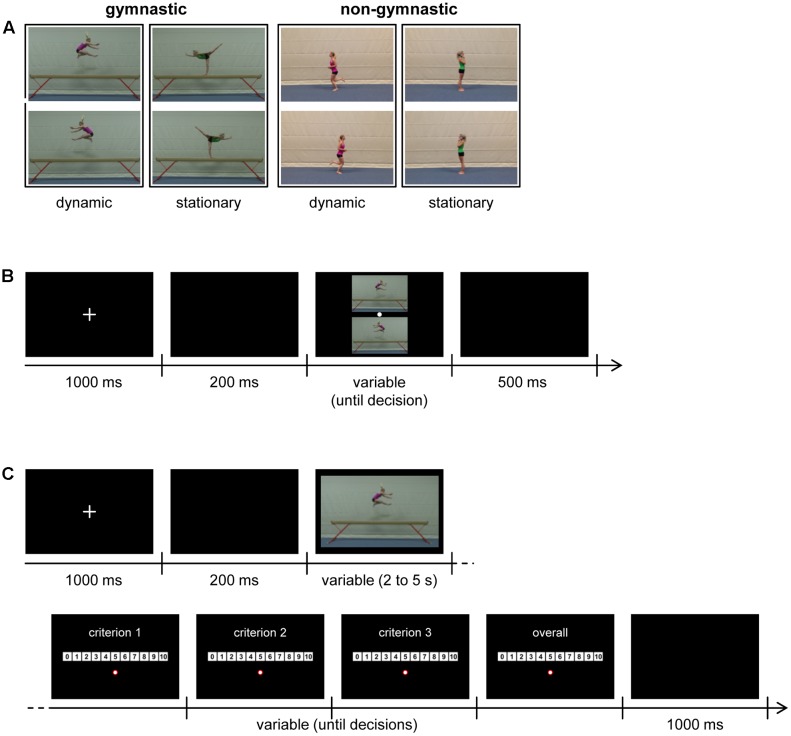
(A) Example picture pairs presented in Experiment 1: dynamic (wolf jump)/stationary (scale fwd.) gymnastic, dynamic (jogging)/stationary (phoning) non-gymnastic. Differences in color settings result from gymnastic and non-gymnastic stimuli being recorded with two different cameras. Importantly, this variation is irrelevant for the analysis of directionality in aesthetic preferences across all trials (“overall”). (B) Illustration of a trial in Experiment 1. (C) Illustration of a trial in Experiment 2. The order of criteria 1–3 (i.e., aesthetics, technique, posture) as well as the horizontal layout of the rating scale (i.e., 0 to 10 or 10 to 0) was counterbalanced across participants.